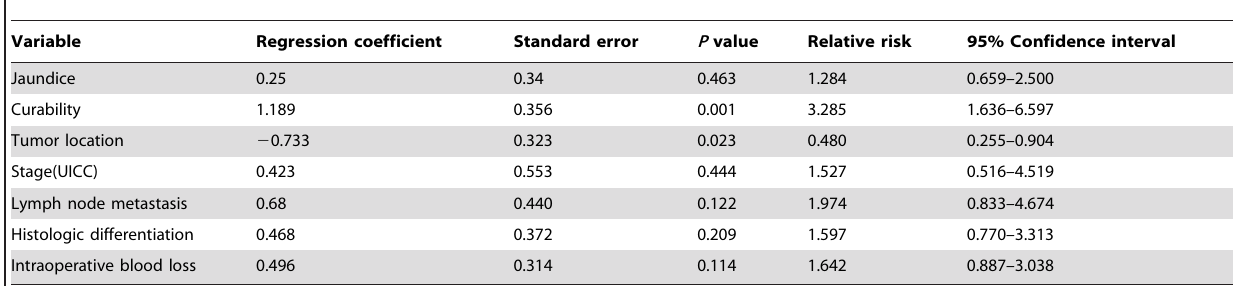
factors (Table 5). The results are shown in Table 5. Noncurative resection and tumor location on gallbladder neck were found to be significant risk factors for poor outcome. Table 5. Results of multivariate